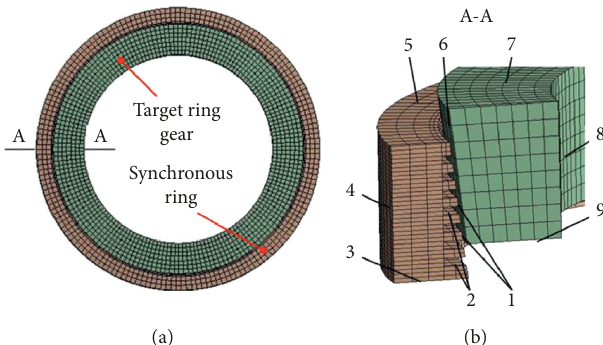
Figure 2: The mesh generation and boundary conditions of the synchronizer.1, 6: heat resource (friction interfaces); 2–5: forced convection heat transfer boundary; 7–9: natural convection heat transfer boundary.